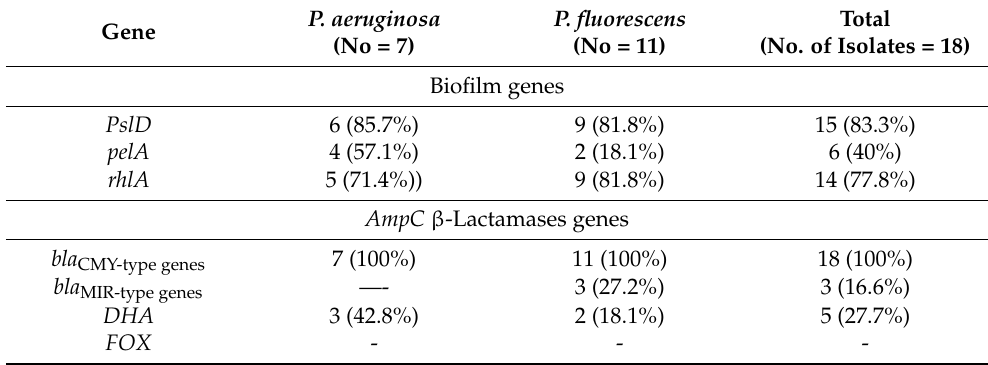
Figure 4. The relation between multidrug resistance and biofilm formation in Pseudomonas spp.